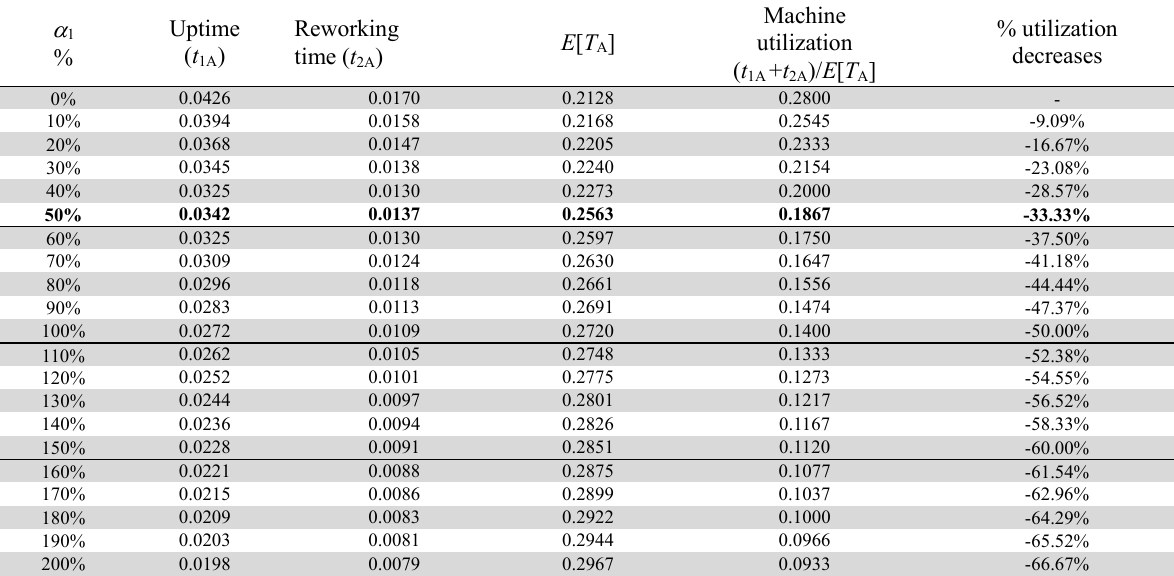
Effect of variations in adjusted factor α 1 on fabrication uptime, reworking time, expected cycle length, machine utilization and its decrease